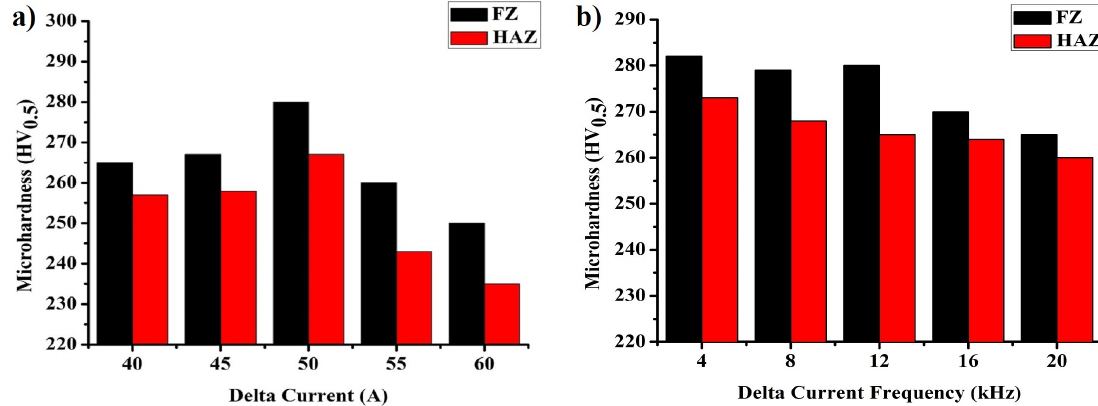
Figure 11: Effect of a) DC and b) DCF on average microhardness of FZ and HAZ